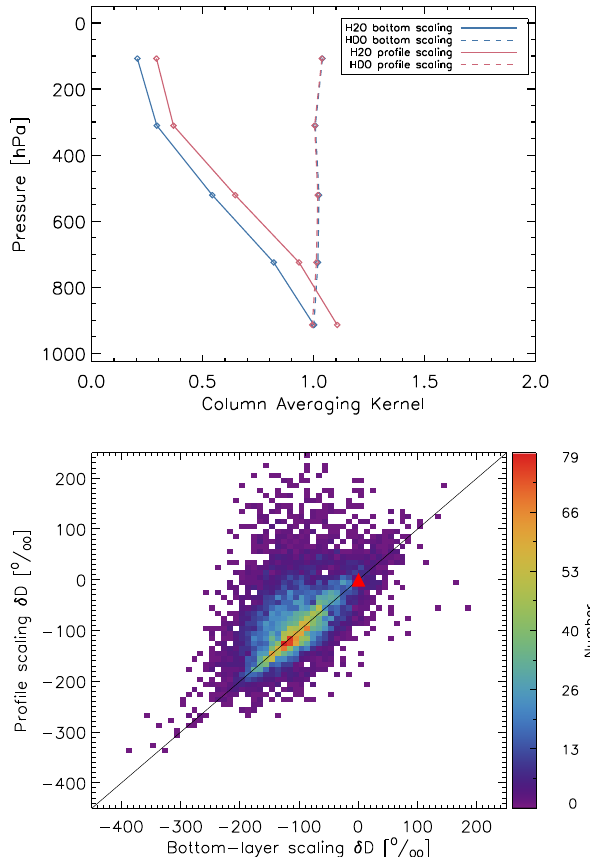
Figure 3. Top: typical column averaging kernels of a bottom layer scaling retrieval (blue) and a profile scaling retrieval (magenta). Bottom: impact of the profile scaling approach with respect to a bottom layer scaling approach for a month of measurements above the Sahara. Both approaches assumed no prior depletion profile for δD (the red triangle shows the a priori δD of 0‰).